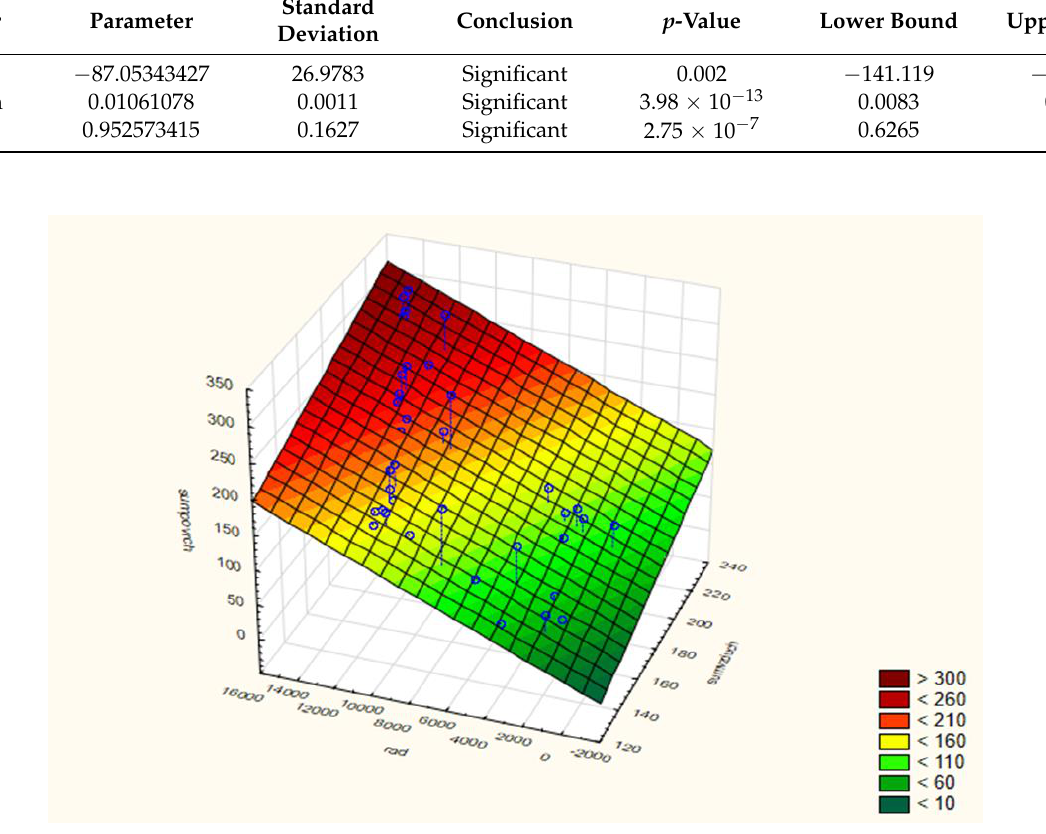
Figure 11. Surface graph of linear dependence between the sum of surface temperatures during the monitored days (sumsurface), sun exposure (rad) and the sum of air temperatures (sumair).